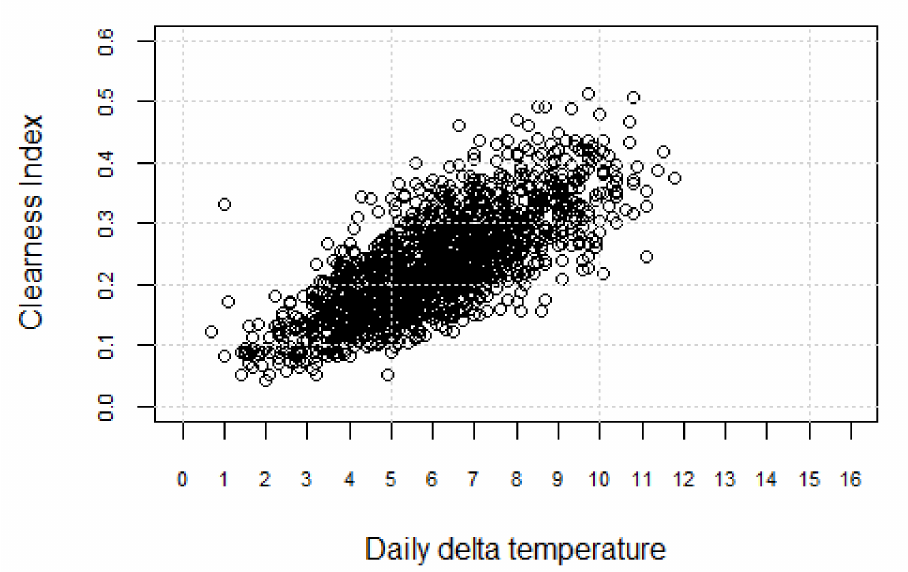
Figure 3. Daily delta of temperature–clearness index for